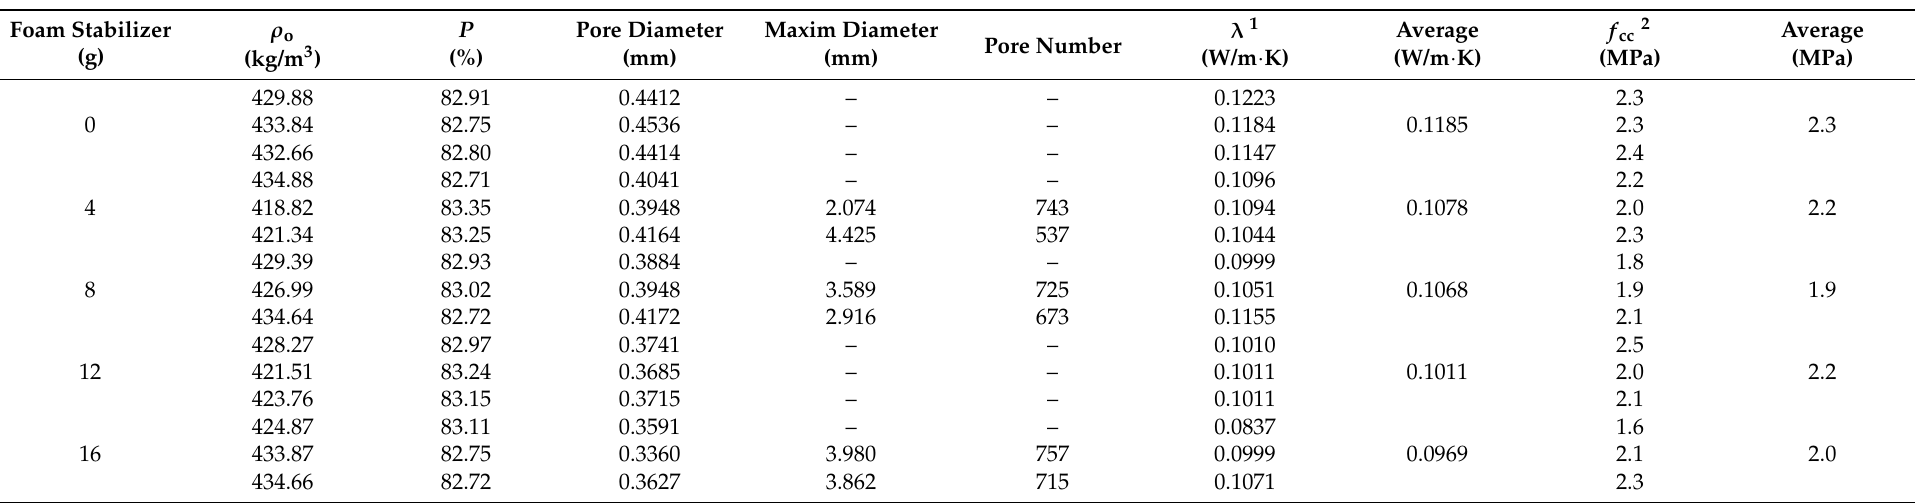
Table 4. Relationship between pores size, thermal conductivity, and compressive strength affected by foam